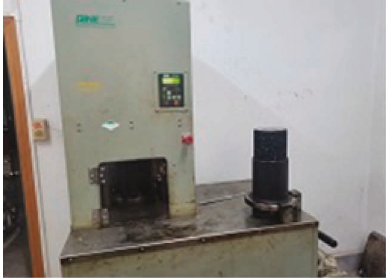
Figure 10: PFC-13 specimens prepared with a gyratory